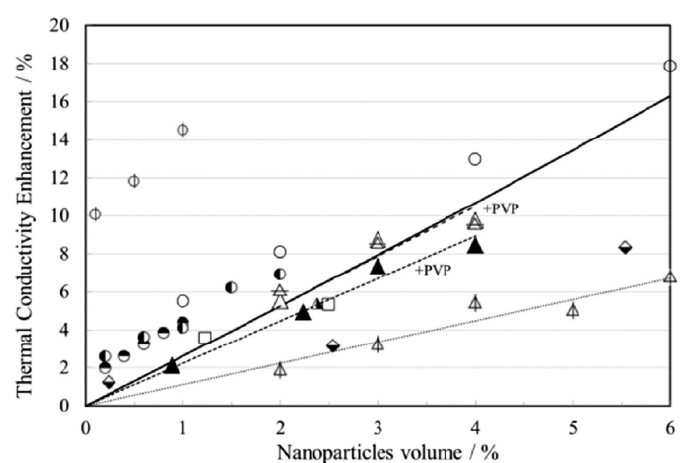
Figure 5. Thermal conductivity enhancement of water in the presence of TiO 2 nanoparticles as a function of the composition for nanoparticles with different diameters [40], at 298.15 K. Bottom-half-solid diamonds, 76 nm, Fedele et al. [41]; ϒ , 40 nm, Zhang et al. [42]; ◐ , 26 nm, Duangthongsuk and ◓ Wongwises [43]; ⌽ , 25 nm, Yoo et al. [44]; , 21 nm, Reddy and Rao [45]; ○ , 21 nm, Yiamsaward et al.[46]; ◮ , 20 nm, Haghighi et al. [47]; − , Hamilton − Crosser model [48]; ▲ , 30 − 50 nm (+PVP), THW [40]; △ , 5 − 15 nm (+PVP), THW [40]; triangle with vertical bar, 5 nm, THW [40]; triangle with